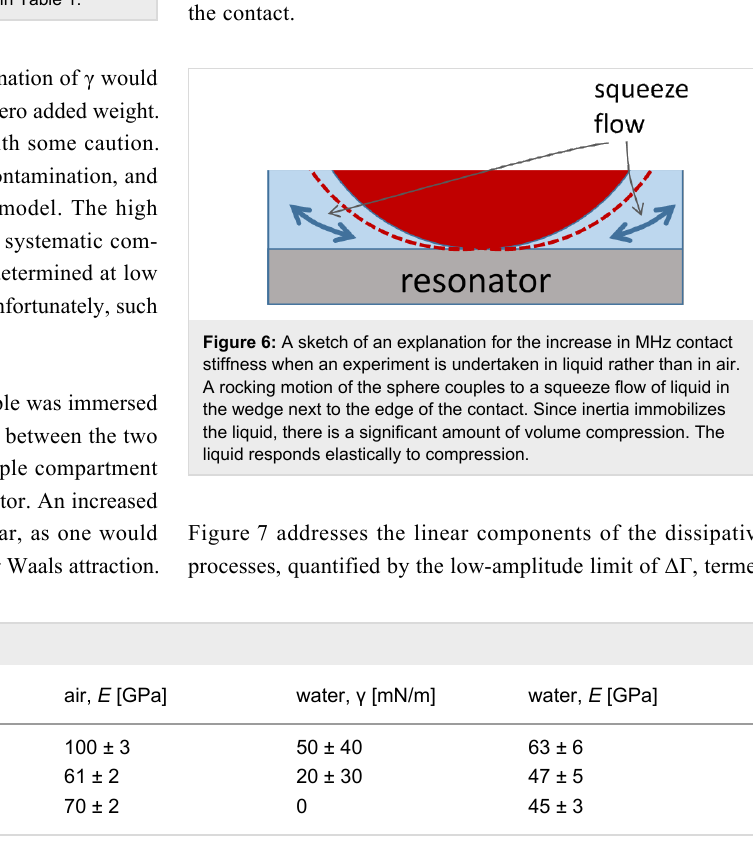
loads are rather high. A more reliable determination of γ would require more data points close to the point of zero added weight.